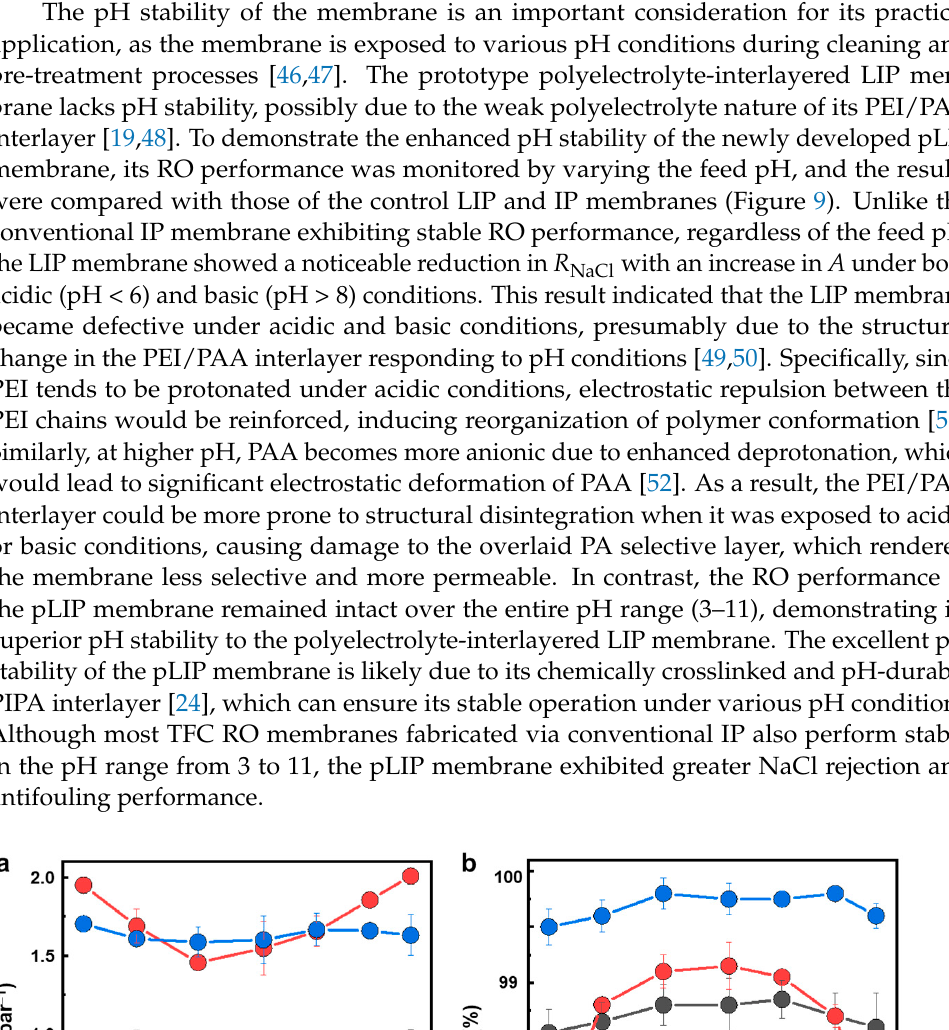
Figure 10. FT-IR spectra of the LIP, pLIP, and conventional IP membranes before (solid line) and after (dashed line) exposure to the acidic (2 h)/basic (2 h) condition. 4. Conclusions In this study, a PA TFC membrane was prepared via LIP, where a PIP/TMC-based PIPA interlayer was introduced to improve the RO performance and pH stability of the prototype polyelectrolyte (PEI/PAA)-interlayered LIP membrane. Similar to the control LIP membrane, the PIPA-interlayered LIP (pLIP) membrane exhibited a much smoother and thinner selective layer structure than the conventional IP-assembled membrane by enabling confined, uniform, and dense MPD deposition and interfacial reaction. Although both the pLIP and control LIP membranes showed higher RO performance than the IP membrane, the pLIP membrane outperformed the LIP membrane and commercial RO membranes. The improved performance was related to the PIPA interlayer, which ena- bled denser MPD deposition and a more confined reaction than the PEI/PAA interlayer. Importantly, the chemically crosslinked and pH-stable nature of the PIPA interlayer re-